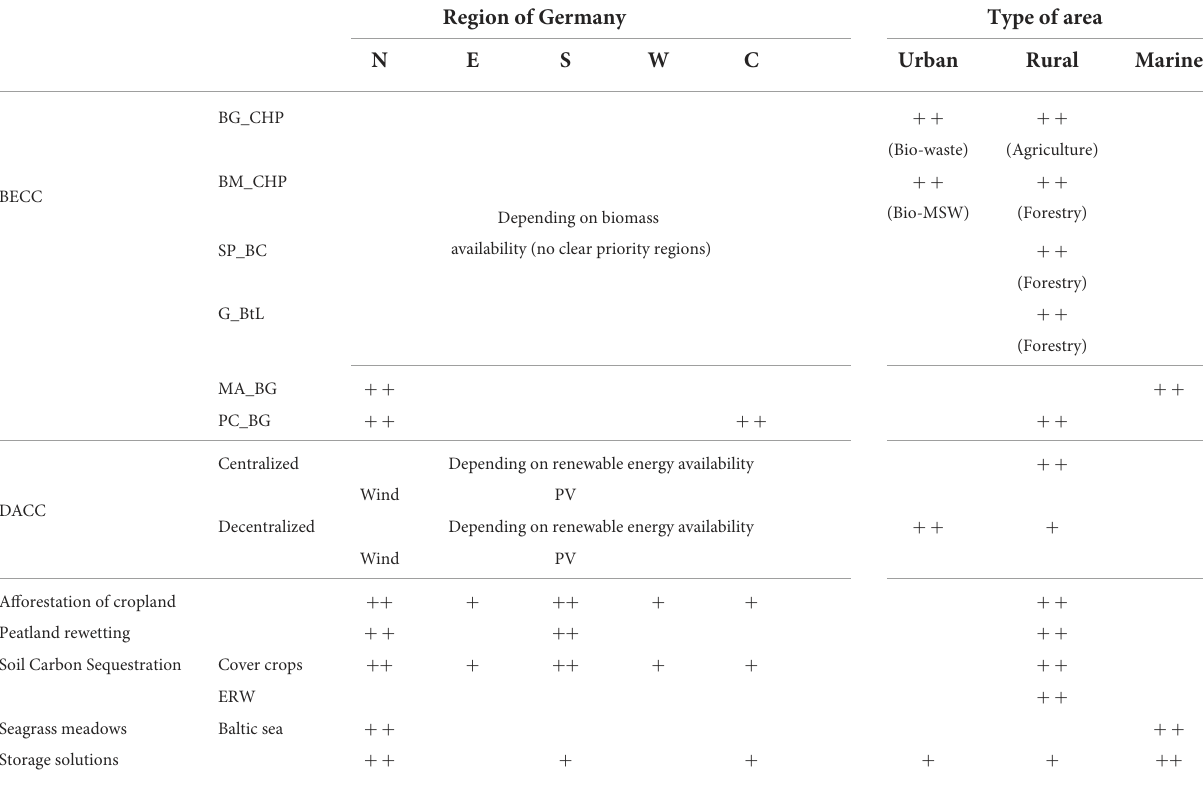
TABLE 3 Distribution patterns of CDR